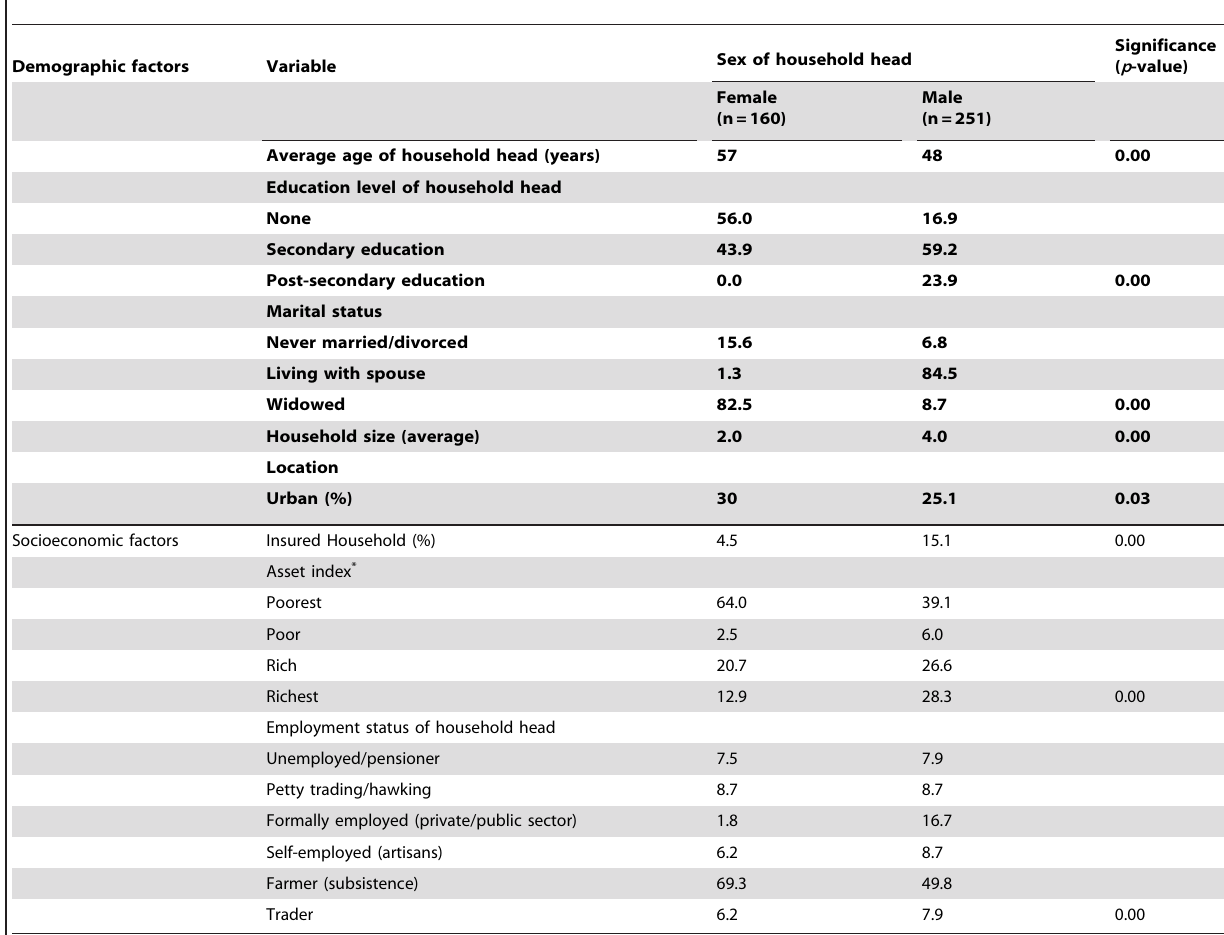
Table 1. Demographic and Socio-Economic characteristics of household heads.